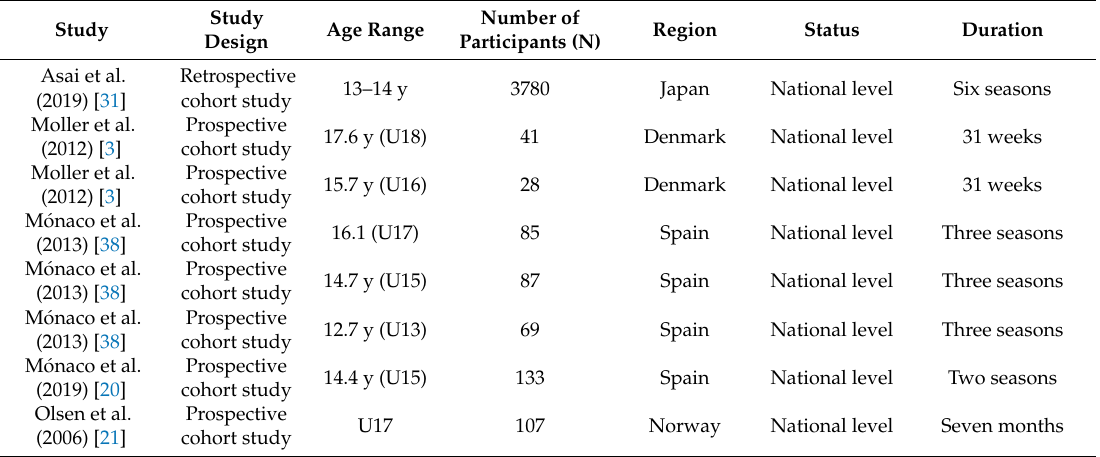
Table 3. Group and intervention characteristics in youth male handball